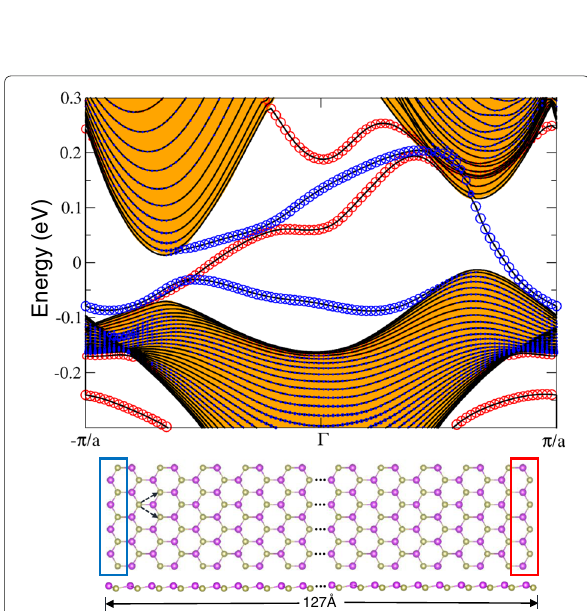
Fig. 7 Band structure along the edge of buckled HfBi zigzag nanoribbon with a = 4.9 Å and the width of 127 Å. Blue (red) circles indicate the contribution from the left (right) edges. The bulk bands are denoted by the orange-filled